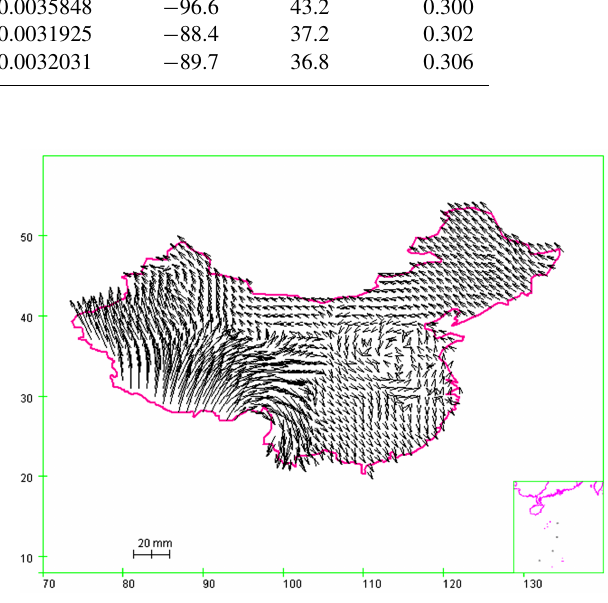
Figure 2. 1 ◦ × 1 ◦ velocity field model.